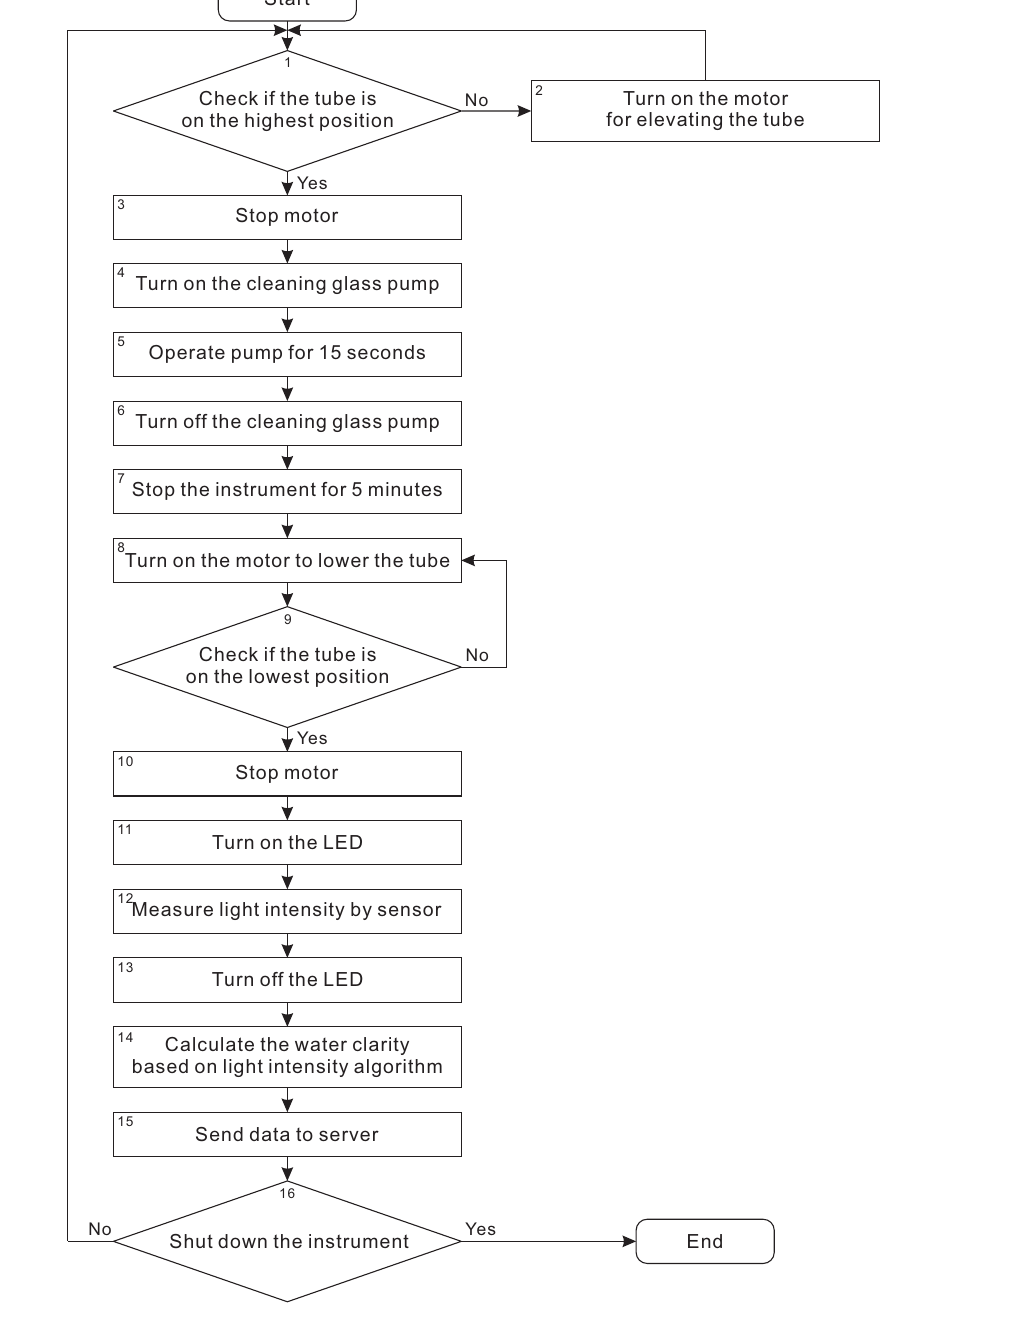
Figure 6. Working principle of the